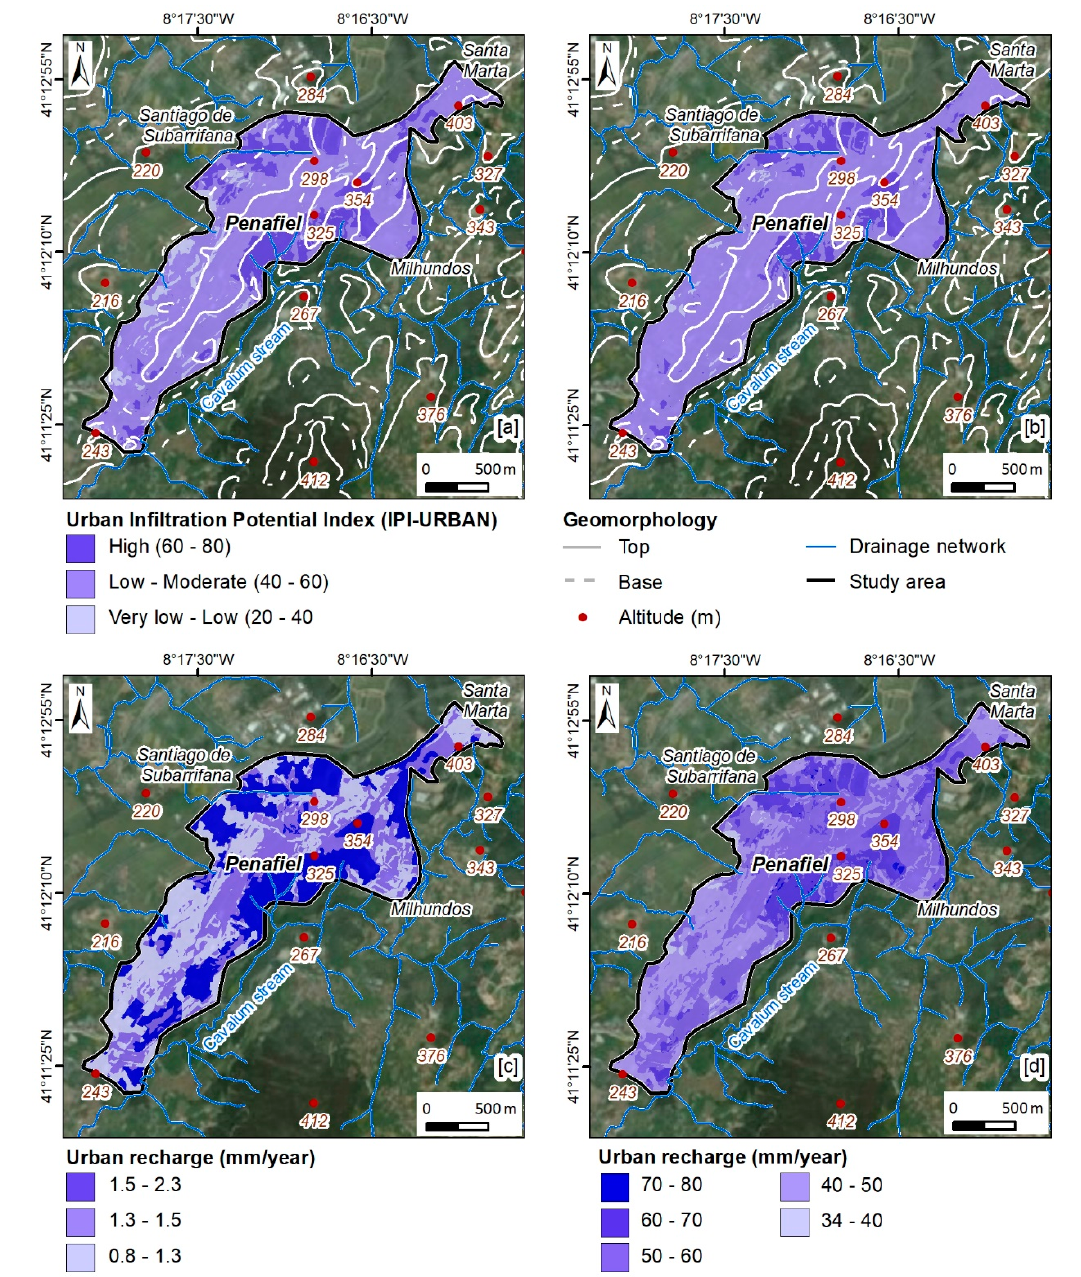
Figure 11. Urban groundwater mapping in the Penafiel urban area (NW Portugal): Urban Potential Infiltration Index (IPI-Urban) (( a ) summer scenario; ( b ) winter scenario); and urban recharge (( c ) summer scenario; ( d ) winter scenario).